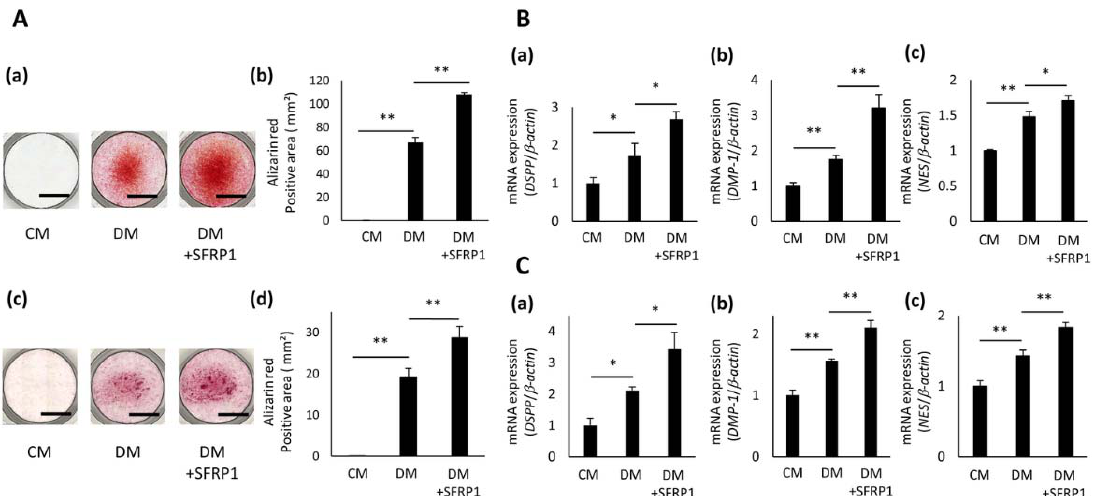
Figure 4. Effects of SFRP1 stimulation on odontoblastic differentiation of hDPCs . ( A ) Odontoblastic differentiation of hDPC-5N and -5I cultured with recombinant SFRP1. Images of Alizarin Red S staining of hDPC-5N ( a ) and -5I ( c ) cultured in CM, DM, or DM with recombinant SFRP1 (100 ng/mL; DM+SFRP1) for 5 days. Experiments were performed in quadruplets. Representative data are shown. The Alizarin Red S-positive area of hDPC-5N ( b ) and -5I ( d ) cultured in CM, DM, or DM+SFRP1 for 5 days. Gene expression of DSPP ( a ), DMP1 ( b ), and NES ( c ) in hDPC-5N ( B ) and -5I ( C ) cultured in CM, DM, or DM+SFRP1 for 3 days. Data are shown as the mean ± standard deviation ( n = 3). * p < 0.05, ** p < 0.01. Scale bars = 5 mm.